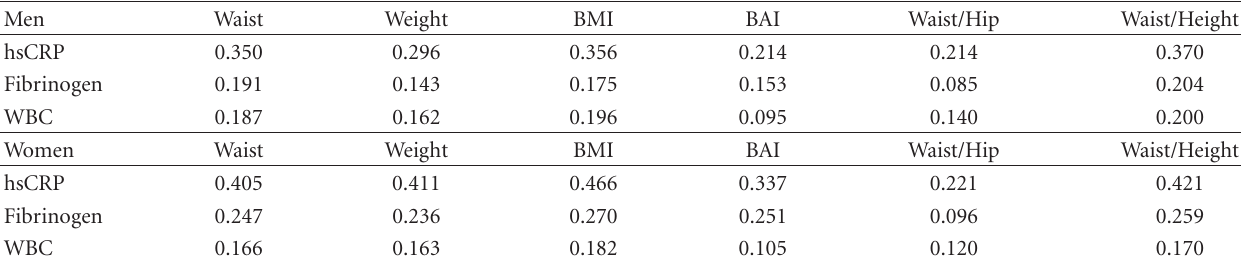
Table 4: Age-adjusted Pearson partial correlation between the di ff erent anthropometric measurements and the di ff erent inflammatory variables ∗ .